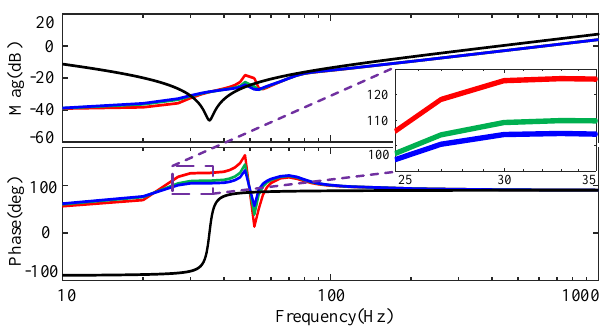
Figure 12. Bode diagram of different damping of active power. Red line: 0.5 D P 0 ; green line: D P 0 ; blue line: 1.5 D P 0.